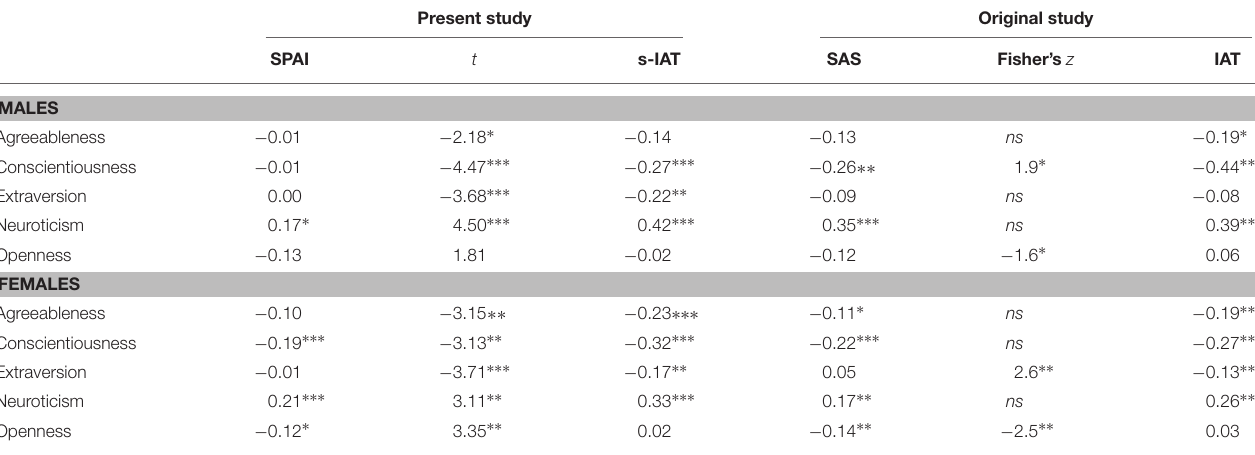
TABLE 3 | Common personality relationships to short internet addiction test (s-IAT)/smartphone addiction inventory (SPAI) by gender. Present study